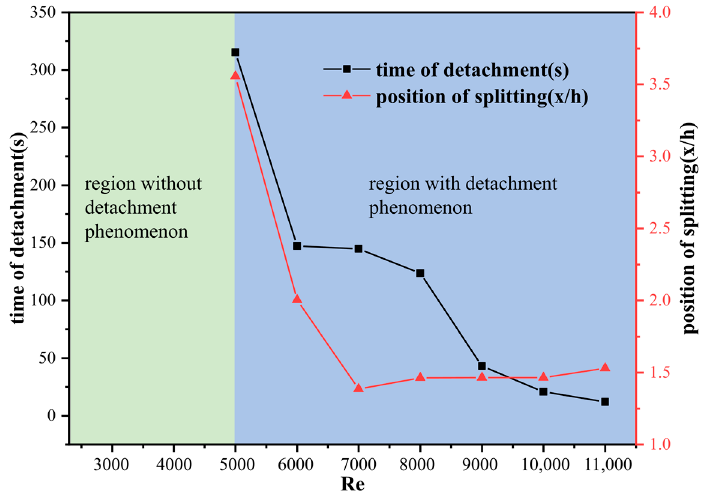
Figure 20. Detachment time and splitting location of bubbles.